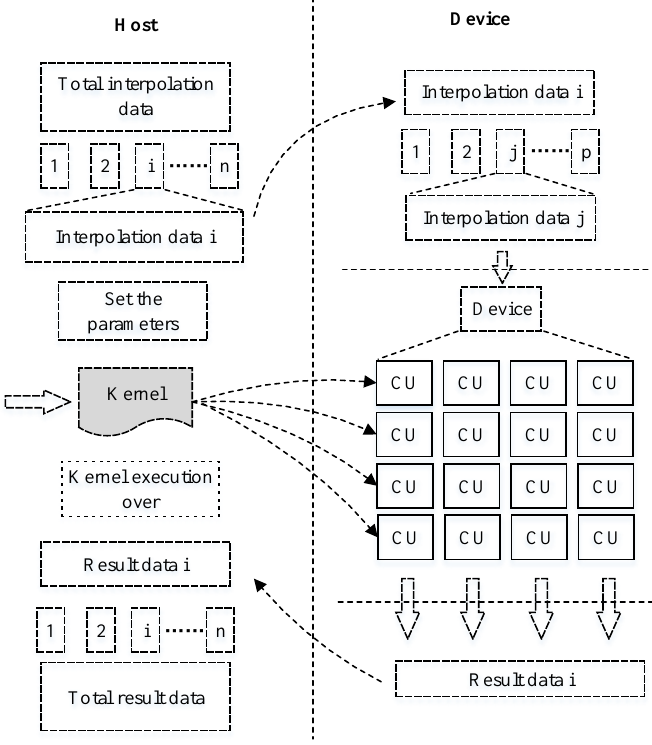
Figure 5. Overview showing the execution of an OpenCL parallel program.